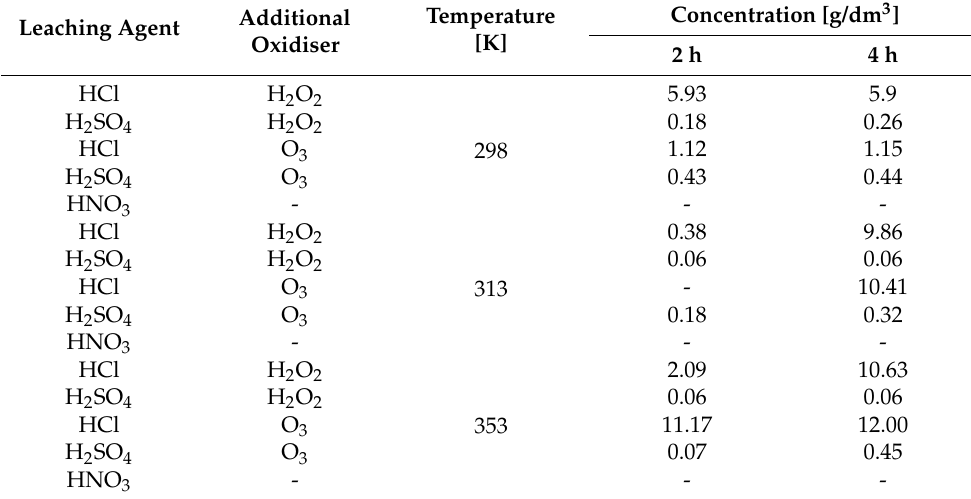
Table 4. Tin concentration obtained after leaching in HNO 3 , HCl, and H 2 SO 4 with the addition of H 2 O 2 or O 3 within 2 h and 4